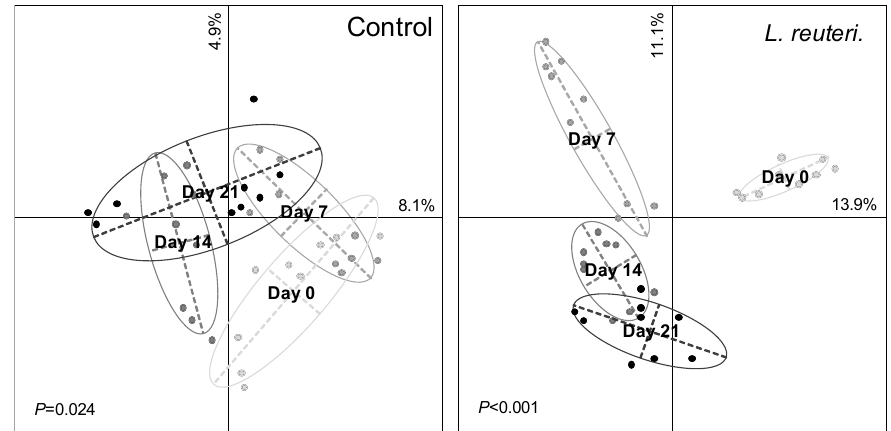
Figure 2. Principal Coordinates Analysis (PCoA) based on the skin bacterial Terminal-Restriction Fragment Length Polymorphism (T-RFLP) profiles during the experiment of control (left) and the introduction of L. reuteri DSM 17938 (right). The letter represents the barycenter of the replicates ( n = 9) for each treatment. The Monte Carlo test-simulated P values (lower left corner) revealed significant differences between the sampling dates. Microorganisms 2020 , 8 , x FOR PEER REVIEW